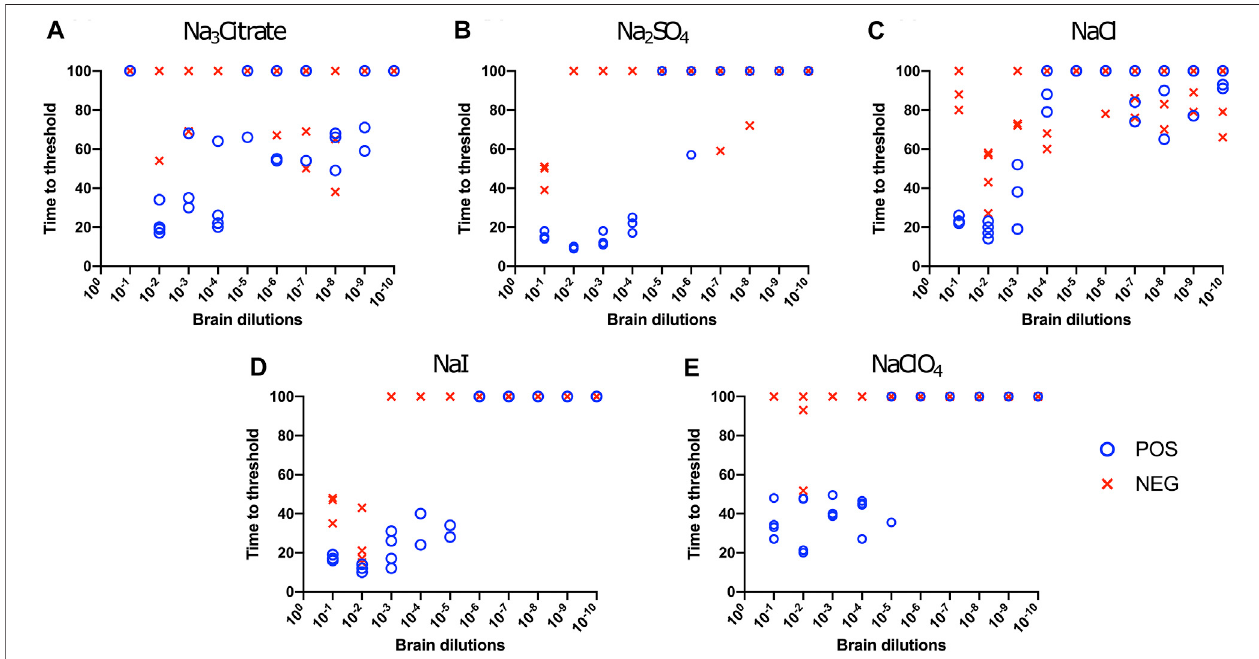
FIGURE 2 | Hofmeister ion effects on RT-QuIC reactions seeded with CWD-positive white-tailed deer brains using BV rPrP substrate. RT-QuIC reactions were seeded with 10 − 1 , 10 − 2, 10 − 3 , 10 − 4, 10 − 5 , 10 − 6 , 10 − 7 , 10 − 8 , 10 − 9 , and 10 − 10 dilutions of brain homogenate from one CWD-positive and one CWD-negative white-tailed deer withtheaddition of0.001%ofSDS.SubstratecontainedbankvolerPrP and400 mMNa 3 citrate (A) ,Na 2 SO 4 (B) ,NaCl (C) ,NaI (D) ,orNaClO 4 (E) .Reactionswere run at 42 ° C.